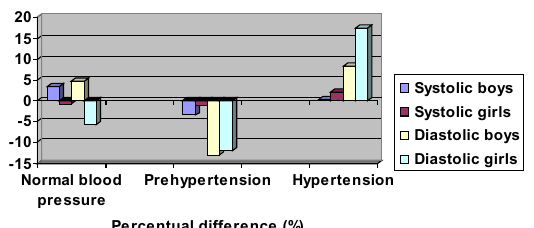
Figure 2 Evaluation of blood pressure in children age between 15 and 20 years